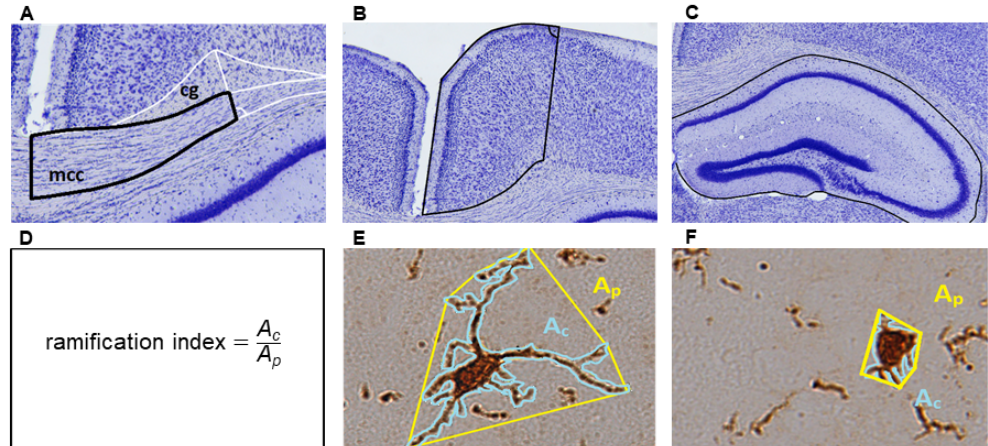
Figure 1. Regions of interest at brain level region 315 (Bregma − 2.3; Nissl staining). ( A ) The medial corpus callosum (mcc) was defined as the corpus callosum area between a perpendicular line dropped from the interhemispheric fissure and a perpendicular line dropped from the peak of the cingulum (cg). ( B ) The medial retrosplenial cortex was defined as the cortical areas above the mcc with a perpendicular line dropped from the brain surface and the peak of the cingulum as lateral boundary. ( C ) The entire hippocampus was defined as a third region of interest (ROI). ( D ) The ramification index was calculated from the ratio of the cell area (A c ) and the projection area (A p ). ( E ) A p is the area of a polygonal object that is defined by the cells’ most prominent projections. A resting microglia cell displays long and thin ramified processes with a relatively high A p (encircled in yellow) and a relatively small A c (encircled in blue). ( F ) An activated microglia cell is characterized by a hypertrophic cell body with retracted processes resulting in a ramification index value close to